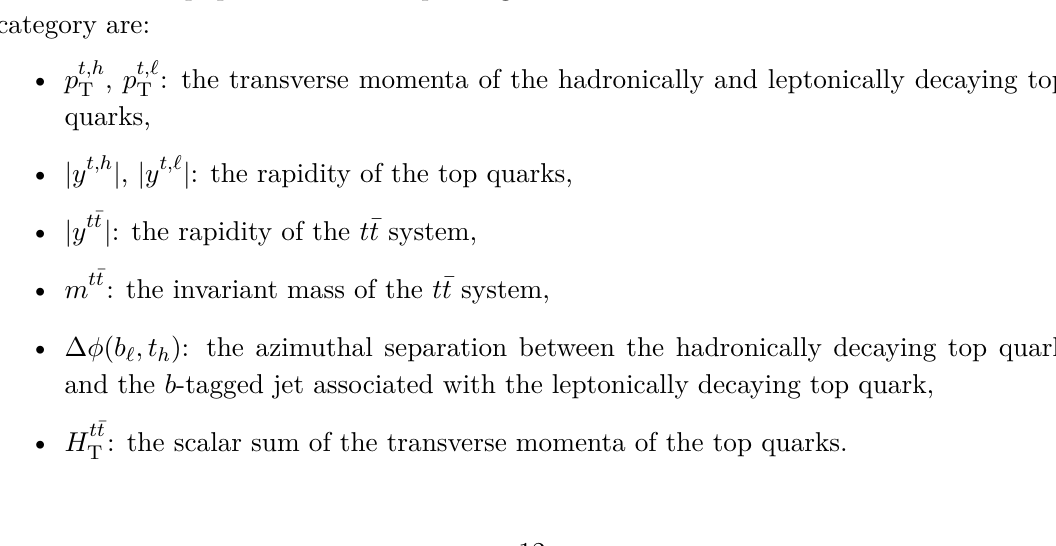
Figure 2. The acceptance and efficiency corrections for p t,h migration matrix for p t,h is shown in (b). For the migration matrix, the numerical value of the bin T is displayed if it is > 1%